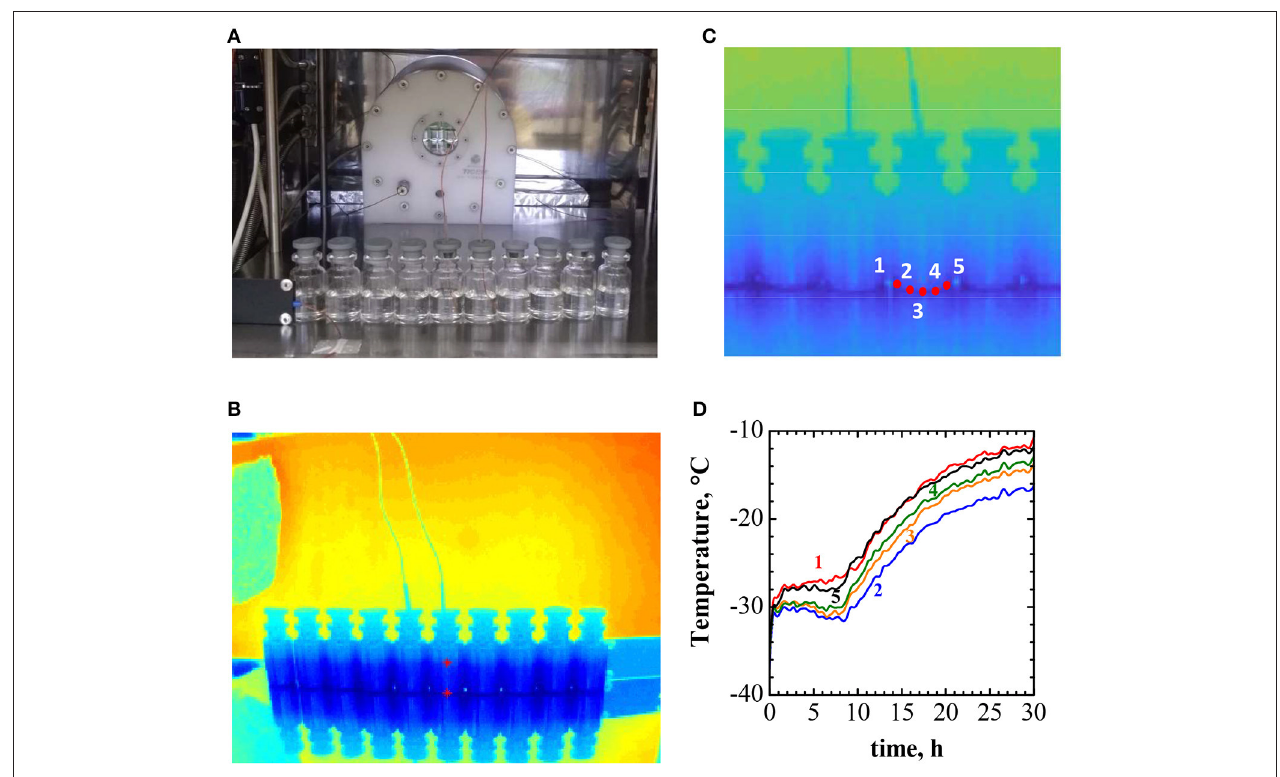
FIGURE 7 | Example of experimental evaluation of temperature gradients in vials during the drying process. (A) The experimental set up, showing the row of 10R vials containing 10% w/w sucrose solution, with a thin-wire thermocouple inserted in two of them, and the IR thermal camera in the background. (B) The IR camera image. (C) Detail of the previous image, showing the five points where the temperature is evaluated. (D) Time evolution of the temperature in the five positions of the vial equipped with a thermocouple shown in (C) .